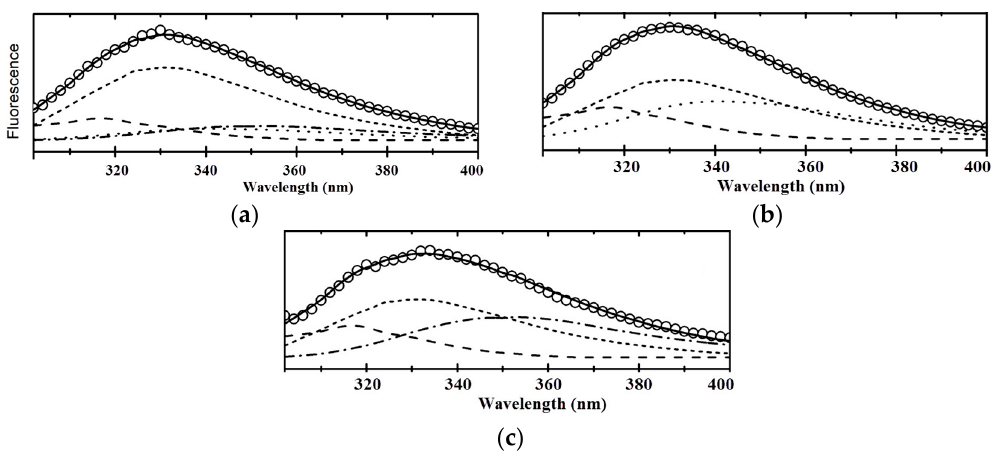
Figure 6. Fitting of the experimental fluorescent spectra data (symbols) of the HSP70 ( a ), HSP70/EIII ( b ) and, HSP70/EIII + MGDG. ( c ) to the theoretical model of the discrete states of tryptophan residues in proteins [45] (continues lines) which are sums of the following spectral components: S (dashed line); I (short dashed line); II (dotted line); III (dash-dotted line). Table 3. Contribution to the fluorescence emission of the spectral forms (%), according to the model of the discrete states of tryptophan residues in proteins Spectral Forms (%) Protein